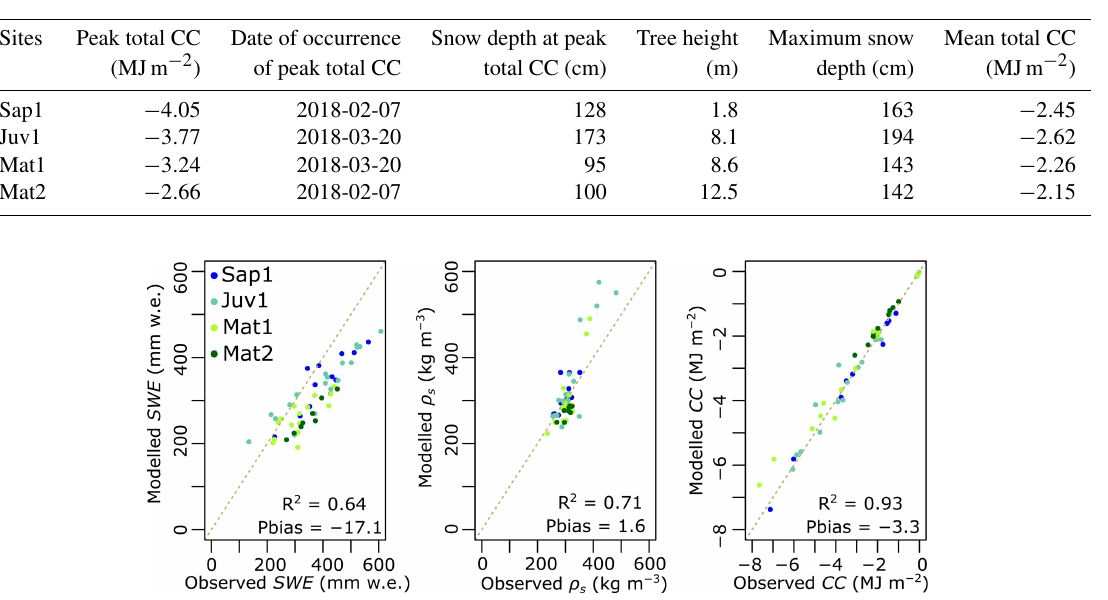
Table 3. Peak total CC, date of occurrence, snow depth, mean tree height at the site, maximum snow depth, and mean total CC over a period of 15 weeks.